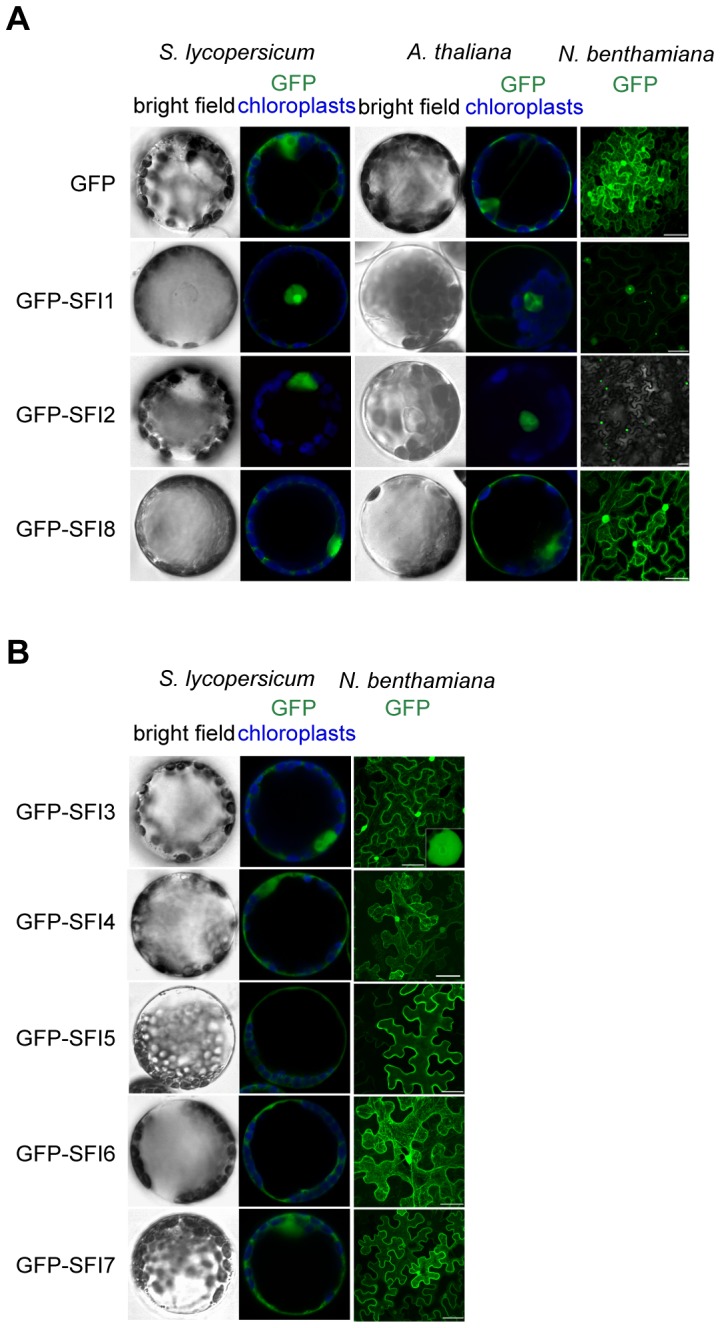
Sub-cellular localization of N-terminally GFP-tagged SFI effectors in S. lycopersicum and A. thaliana protoplasts and in N. benthamiana leaves.(A, B) Mesophyll protoplasts and N. benthamiana leaves were monitored using confocal microscopy 12 h and 48 h after transfection with a p35S-GFP-effector construct, respectively. Representative optical sections of bright field and merged GFP (in green) and chloroplast (in blue) fluorescence images are shown for protoplasts as indicated.